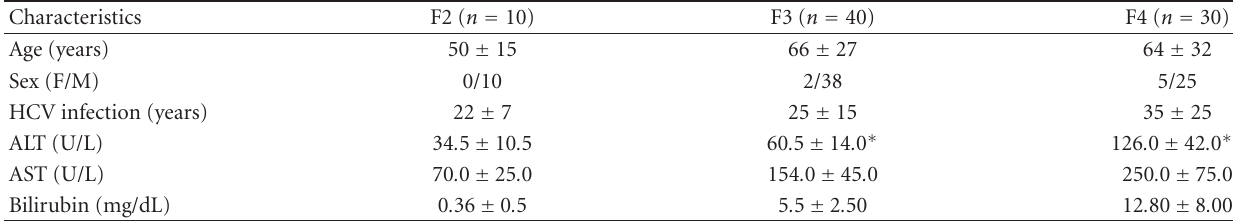
Table 3: Baseline characteristics ALD infected with